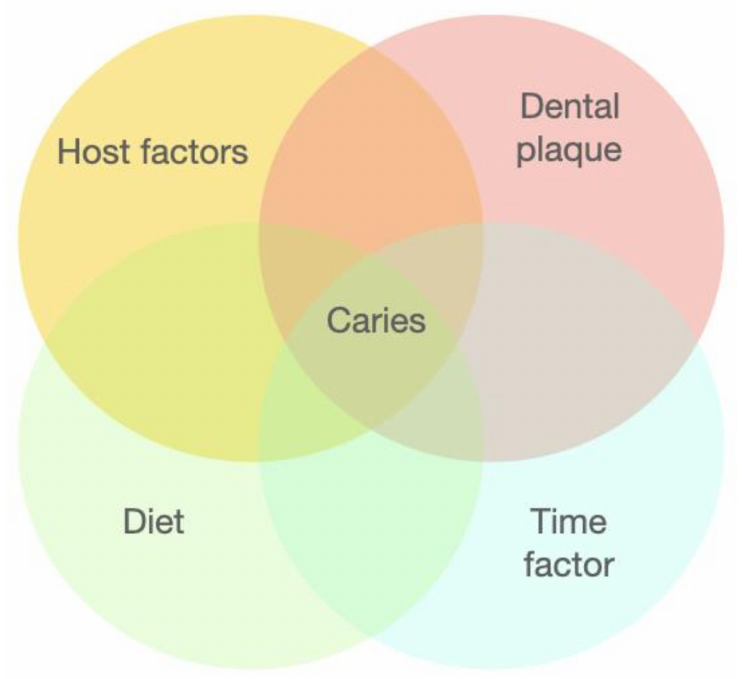
Figure 1. Overview diagram on factors contributing to the formation of the carious process.